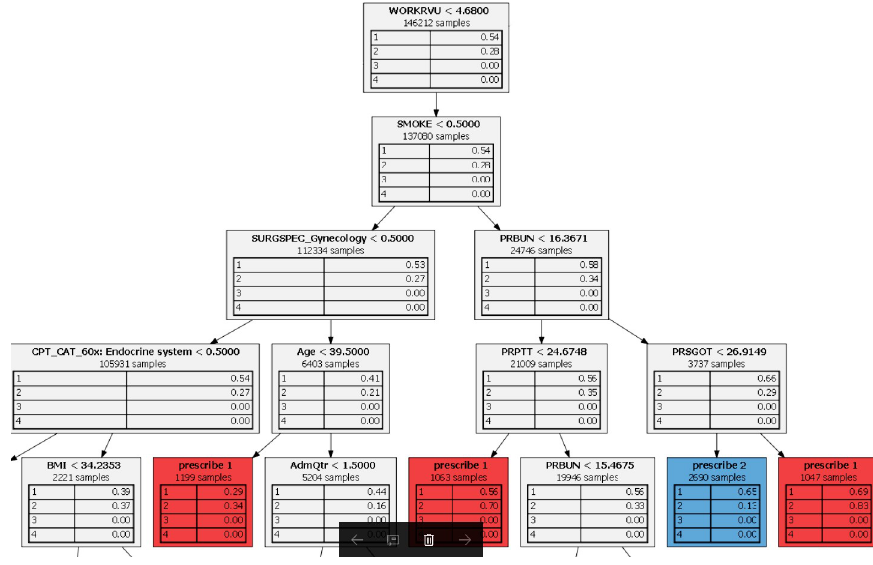
Fig 1. An instance of an Optimal Prescriptive